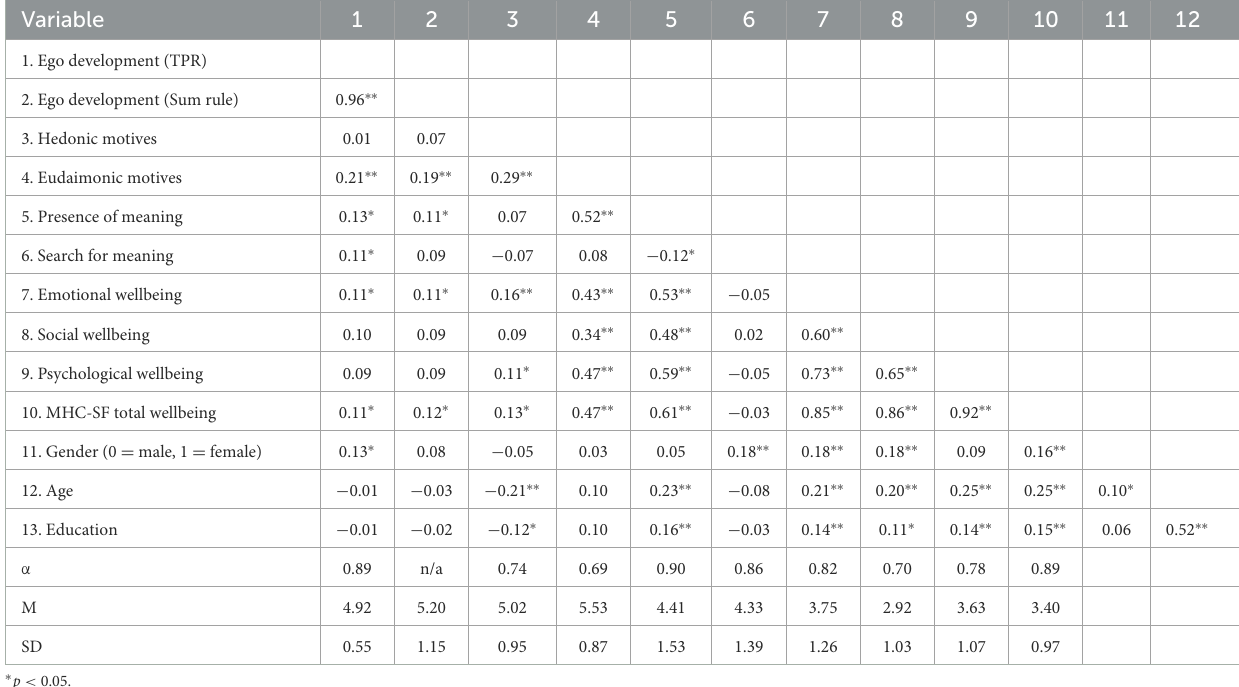
PairwiseNrangesfrom345to362.Spearmancorrelationsaregivenforcategoricalvariables(egodevelopmentbasedonsumruleandeducation).